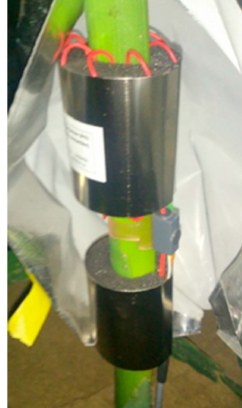
Figure 2. Example of sap flow system EMS 62, consisting of a heating element installed in the upper section (red wires) and two insulated thermocouples inserted 15 cm apart.